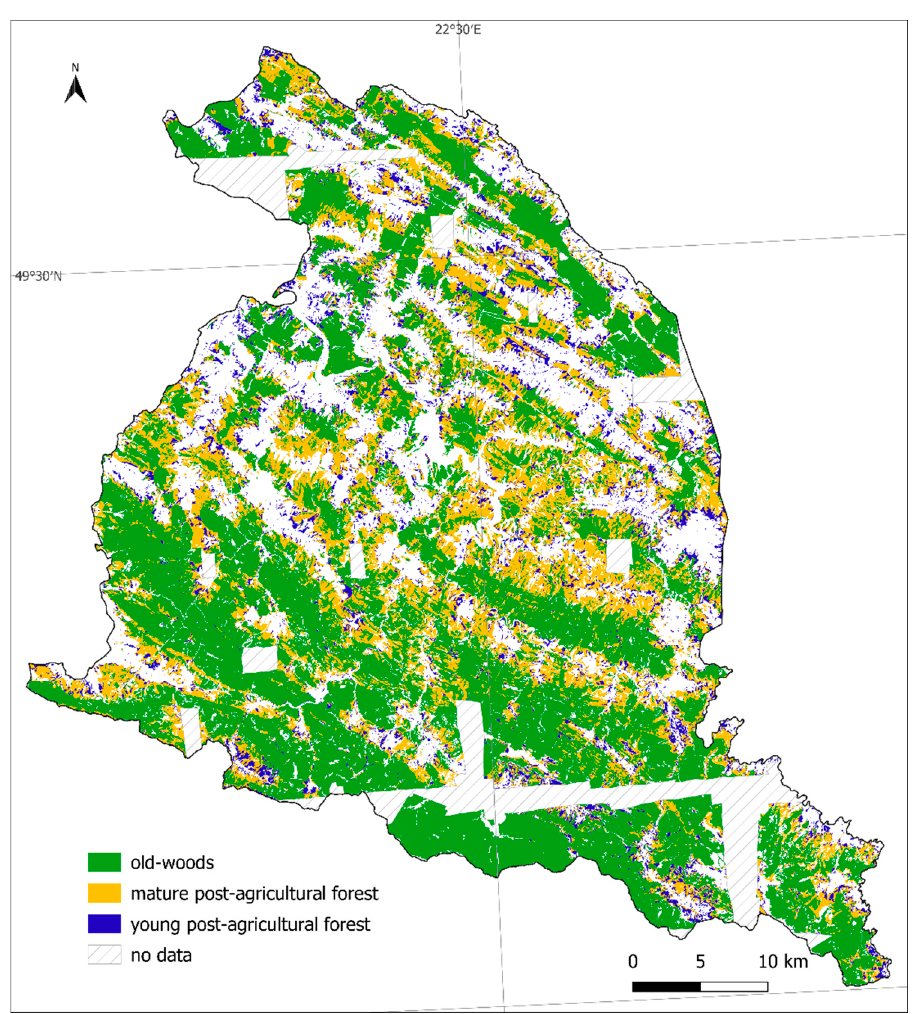
Figure 4. The map of post-agricultural forest and old-woods in the Polish Eastern Carpathians. Old-woods—forest that existed before 1944; mature post-agricultural forest—post-agricultural forest that developed before 1969; young post-agricultural forest—forest that developed after 1969; no data—missing aerial photos from 1944 .